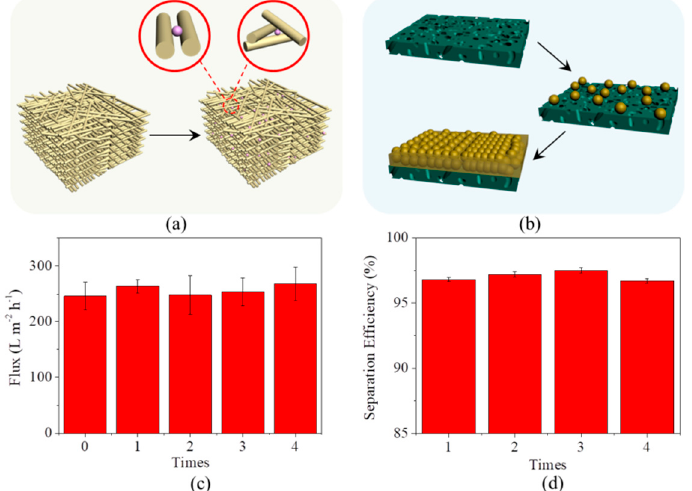
Figure 8. ( a ) Scheme for the illustration of the location of oil drops after being rejected by microfiber filter; ( b ) Scheme for the illustration of the location of oil drops after being rejected by PVDF membrane; ( c ) Fluxes of microfiber filter as a function of clean times; ( d ) Separation efficiencies of microfiber filter as a function of clean times.